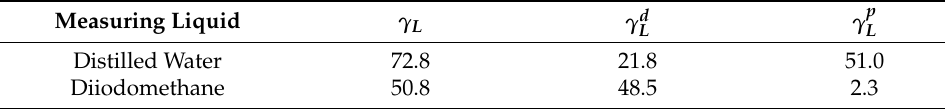
Table 2. Surface tension values of measuring liquids (mJ/m 2 ) [34].